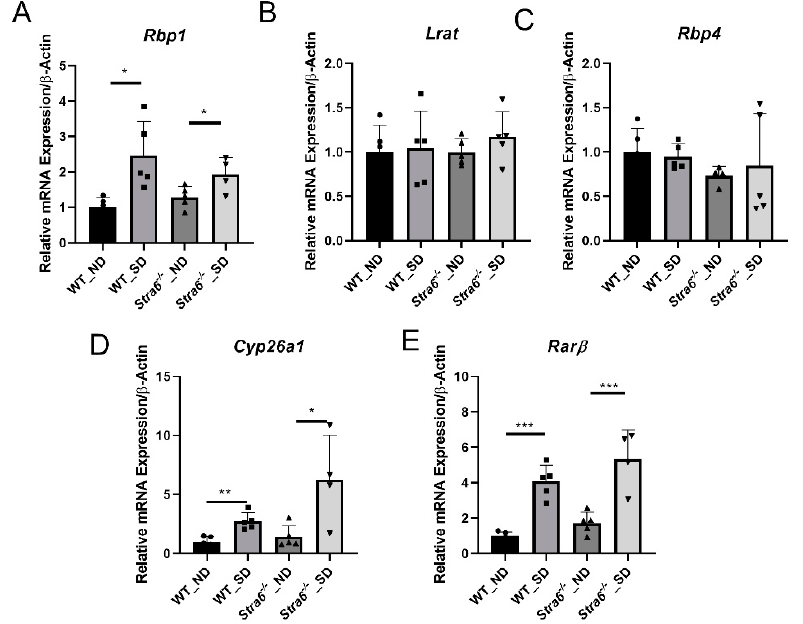
Figure 5. Diabetes affects hepatic retinoid signaling . Quantitative RT-PCR analysis for Rbp1 , Lrat , Rbp4 , Cyps6a1 , and Rar β mRNA expression levels was performed for the total RNA preparation of the liver of long-term diabetic and non-diabetic WT and Stra6 -/- mice. ( A ) Rbp1 mRNA level. ( B ) Lrat mRNA level. ( C ) Rbp4 mRNA level. ( D ) Cyp26a1 mRNA level. ( E ) Rar β mRNA level in non-diabetic (ND) and diabetic (SD) WT and Stra6 -/- mice. β -actin was used as an internal control. The data are represented as means ± SD from at least five animals per genotype and condition. The statistical analysis was performed using a two-tailed t- test analysis. * p < 0.05, ** p < 0.005, and *** p < 0.0001.